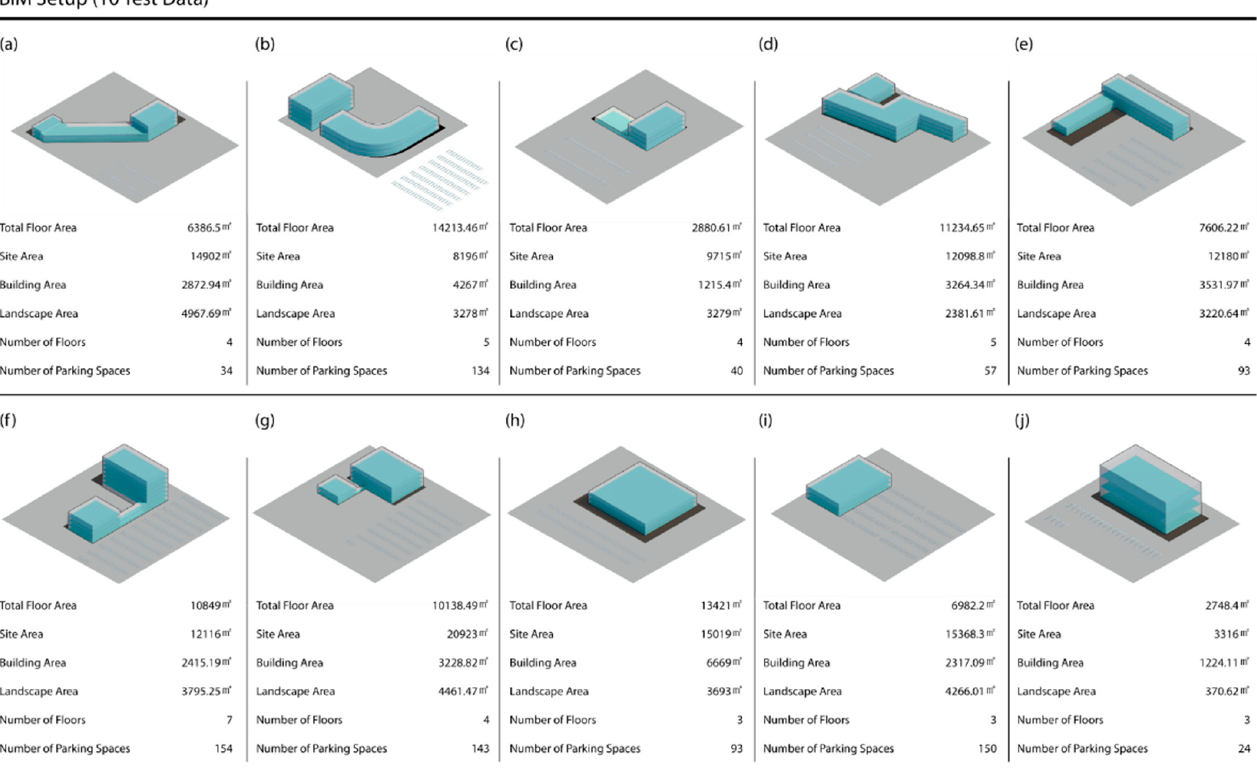
Figure 9. Test BIM setup for validation.